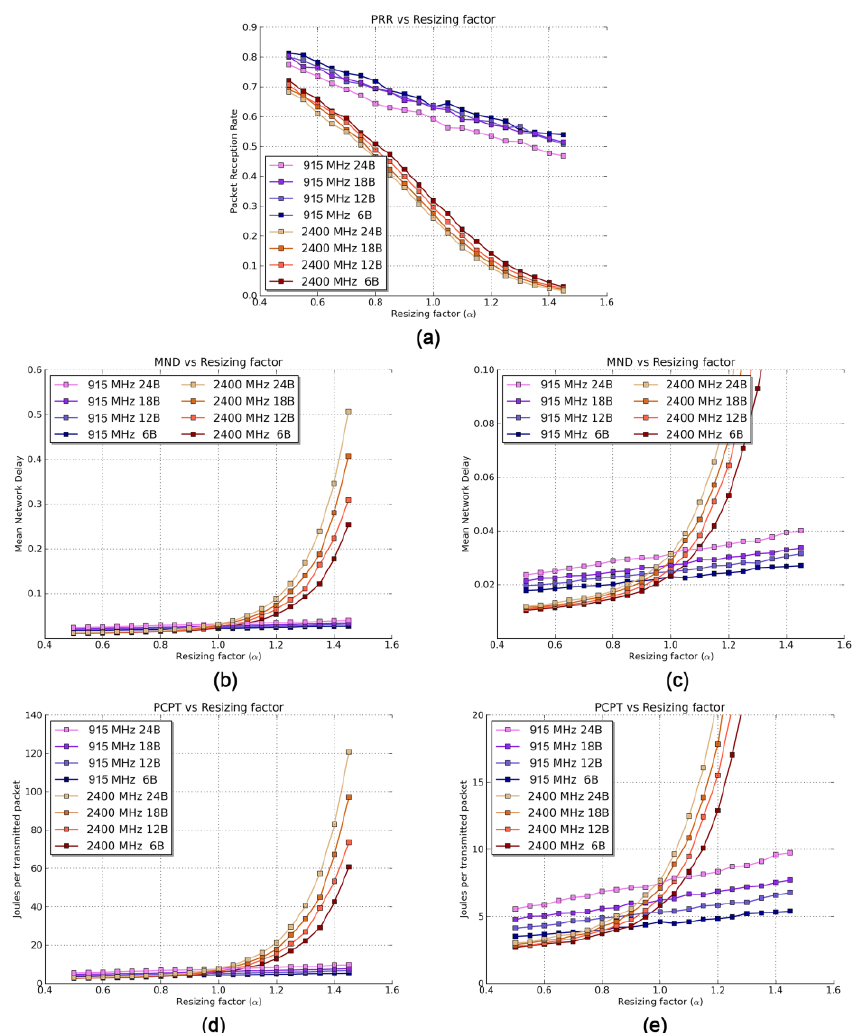
Figure 6. Results of Scenario 2 for different packet sizes and resizing factors. ( a ) PRR, ( b ) MND, ( c ) Zoom of MND, ( d ) PCPT, and ( e ) Zoom of PCPT.